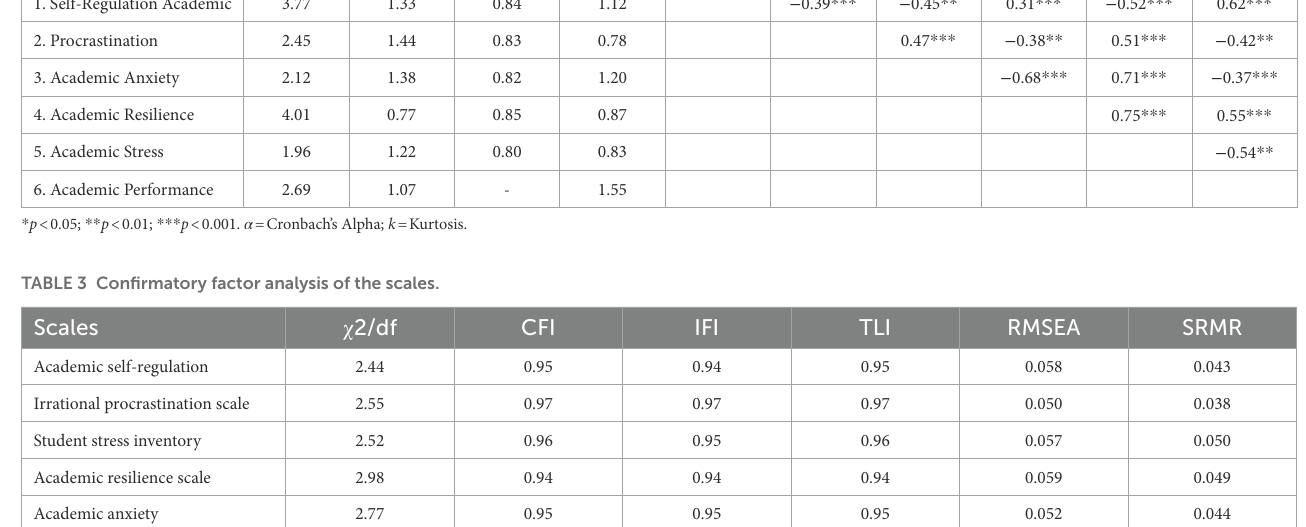
TABLE 2 Descriptive analyzes, internal consistency, kurtosis and bivariate correlations. Factors